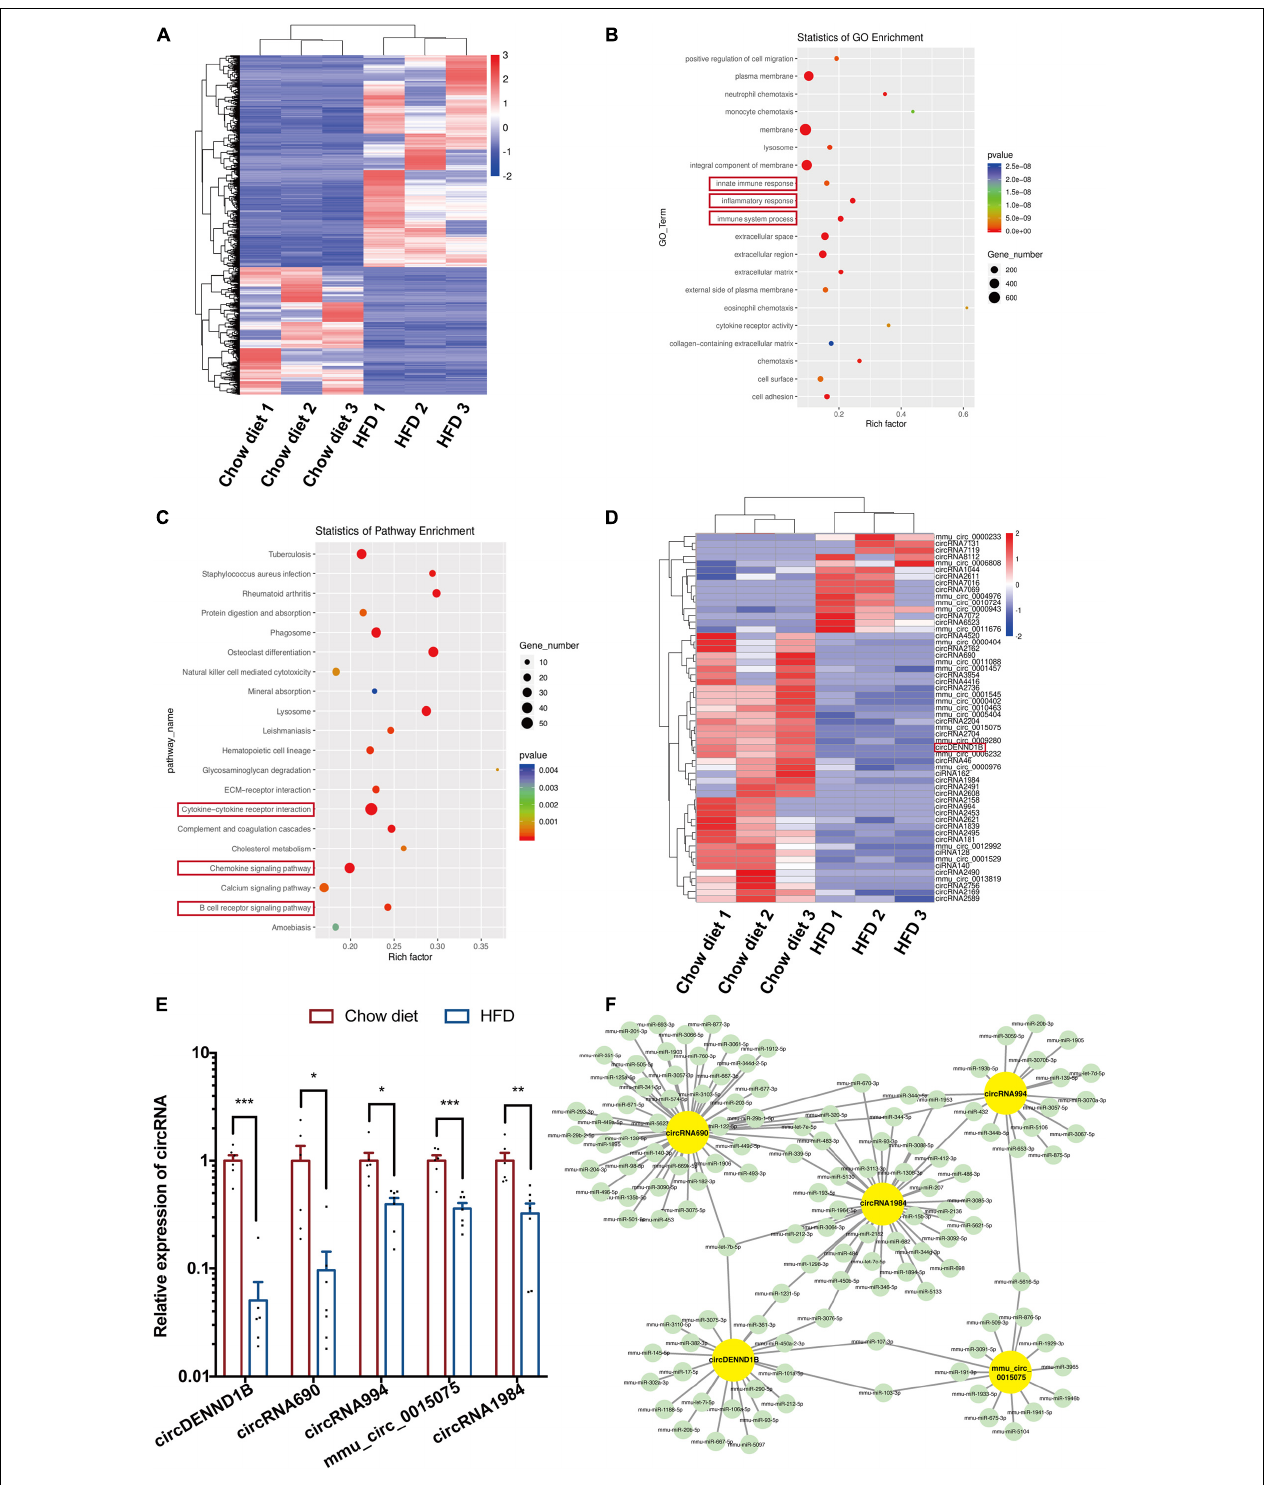
FIGURE 1 | Differentially expressed circular RNA/mRNA in mouse aortas. (A) Heatmap of DEGs in the aortas of HFD-fed compared to chow diet-fed mice. (B) The top 20 GO terms of detected DEGs. The enriched GO terms are ordered alphabetically. (C) Scatterplots of the top 20 differentially regulated pathways identified in KEGG. The KEGG terms are ordered alphabetically. (D) Heatmap of the 56 identified DECs in mouse aortas. (E) qRT-PCR results confirming that five DECs are downregulated in atherosclerotic aortas, Data were normalized to GAPDH ( n = 6 per group). (F) The ceRNA module network of five identified DECs. The yellow nodes represent circRNAs, and the green nodes represent predicted miRNAs. * p < 0.05, ** p < 0.01, *** p < 0.001.